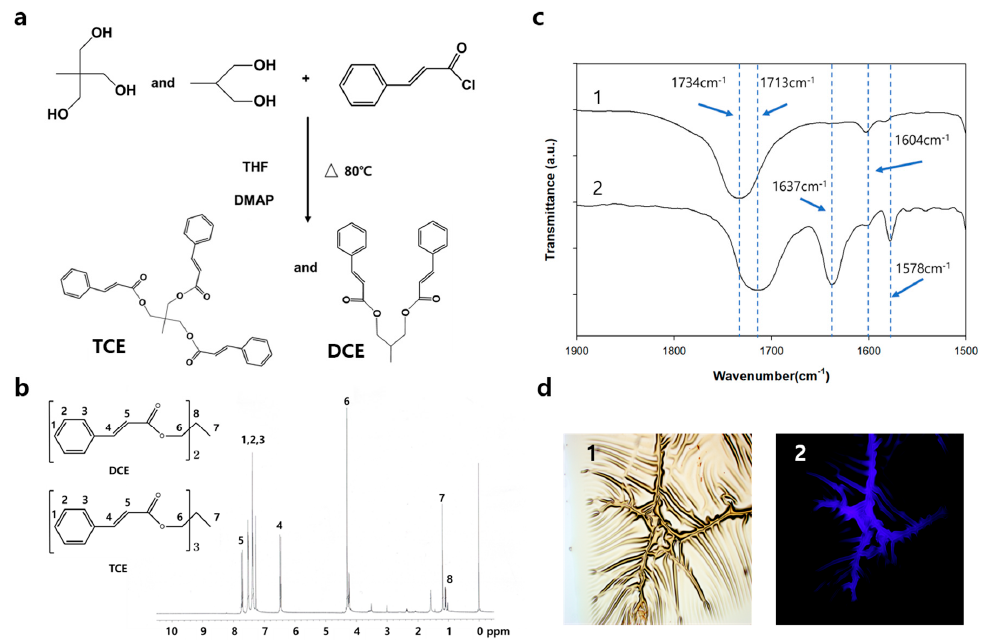
Figure 1. Synthesis and analysis of TCE and DCE monomers. ( a ) The molecular structures of precursors, TCE and DCE after synthesis. ( b ) 1 H NMR spectrum of the TCE and DCE co-monomer. (CDCl 3 , 300 MHz) 1.17 (3H (CH 3 ) and s), 4.29 (6H (3 × OCH 2 ) and s), 6.45 (3H (3 × phCH) and d), 7.33 7.51 (15H (aromatic), m), 7.70 (3H (3 × phCHCH) and d). ( c ) Comparison of FT-IR spectra of poly (TCE-co-DCE) film without (1) and with (2) exposed monomers. ( d ) Optical (1) and fluorescence (2) photograph images of poly (TCE-co-DCE) film.